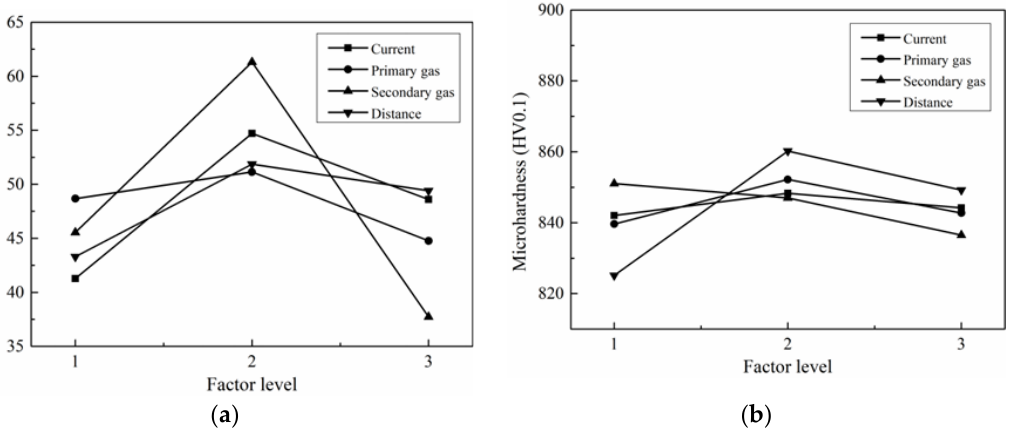
Figure 2. The factor effect of plasma spraying parameters on ( a ) bonding strength; ( b ) micro-hardness for the Fe-Cr-B-C coating.